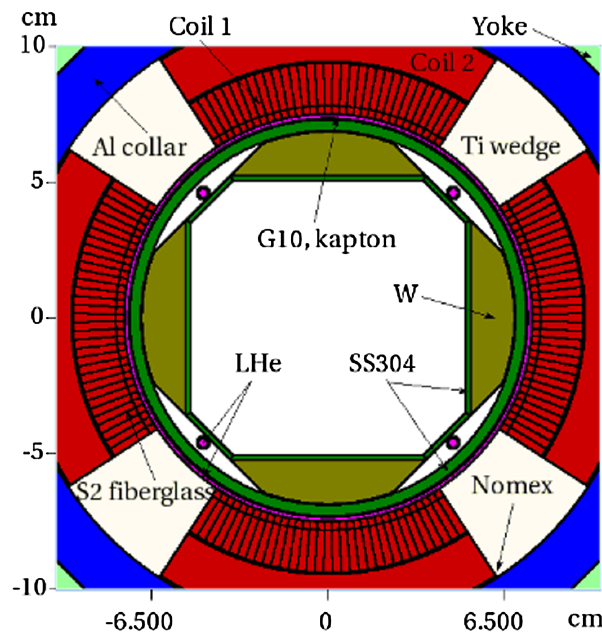
FIG. 3. Details of the FLUKA - MARS model in the innermost region of the Q1 quadrupole. The major difference between Q2-Q3 and Q1 is that the tungsten liner in the former is significantly thinner than that in the latter. The Nb 3 Sn coils are homogenized; inner coils are subdivided azimuthally and radially for scoring. Nomex and S2 fiberglass insulating inserts are not included in the model; corresponding labels indicate their locations as discussed in the text for Table II below.